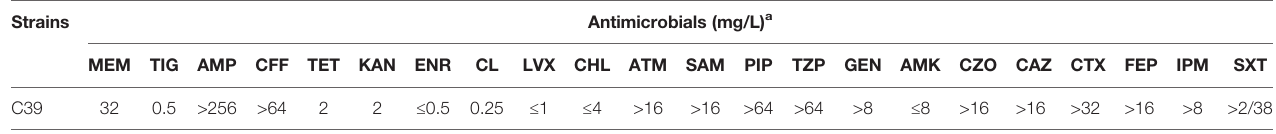
TABLE 1 | Antimicrobial susceptibility pro fi les of the K. pneumoniae strain C39 against different antimicrobials. Strains Antimicrobials (mg/L) a